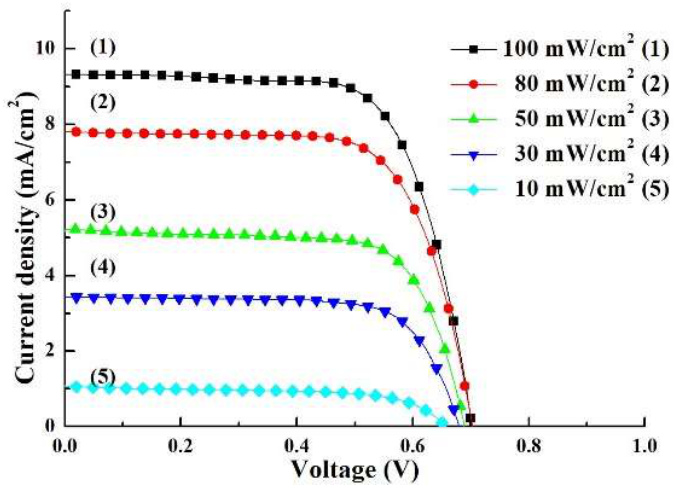
Figure 11. Current density–voltage curves of the DSSC based on TANP under different illuminations.